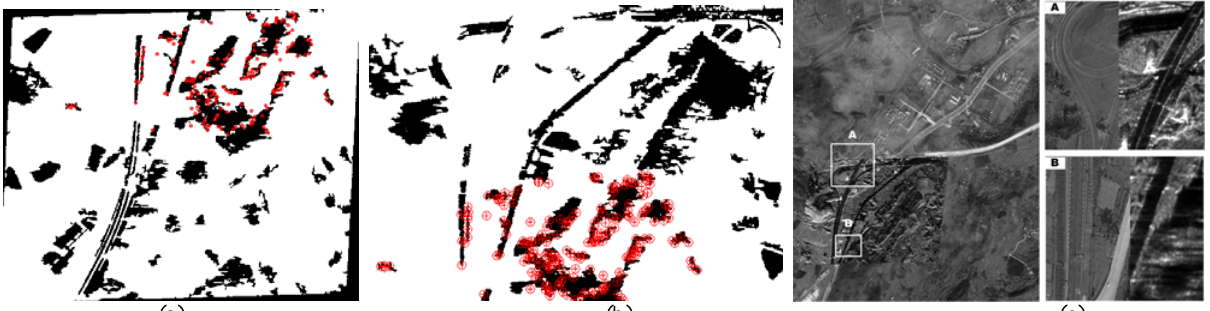
Figure 4. Registration result using level set segmentation and matching method for sequence SAR image 2. (a) Image segment result and final set of tie points of optical image. (b) Image segment result and final set of tie points of SAR image. (c) Overlay result for sequence image 2.